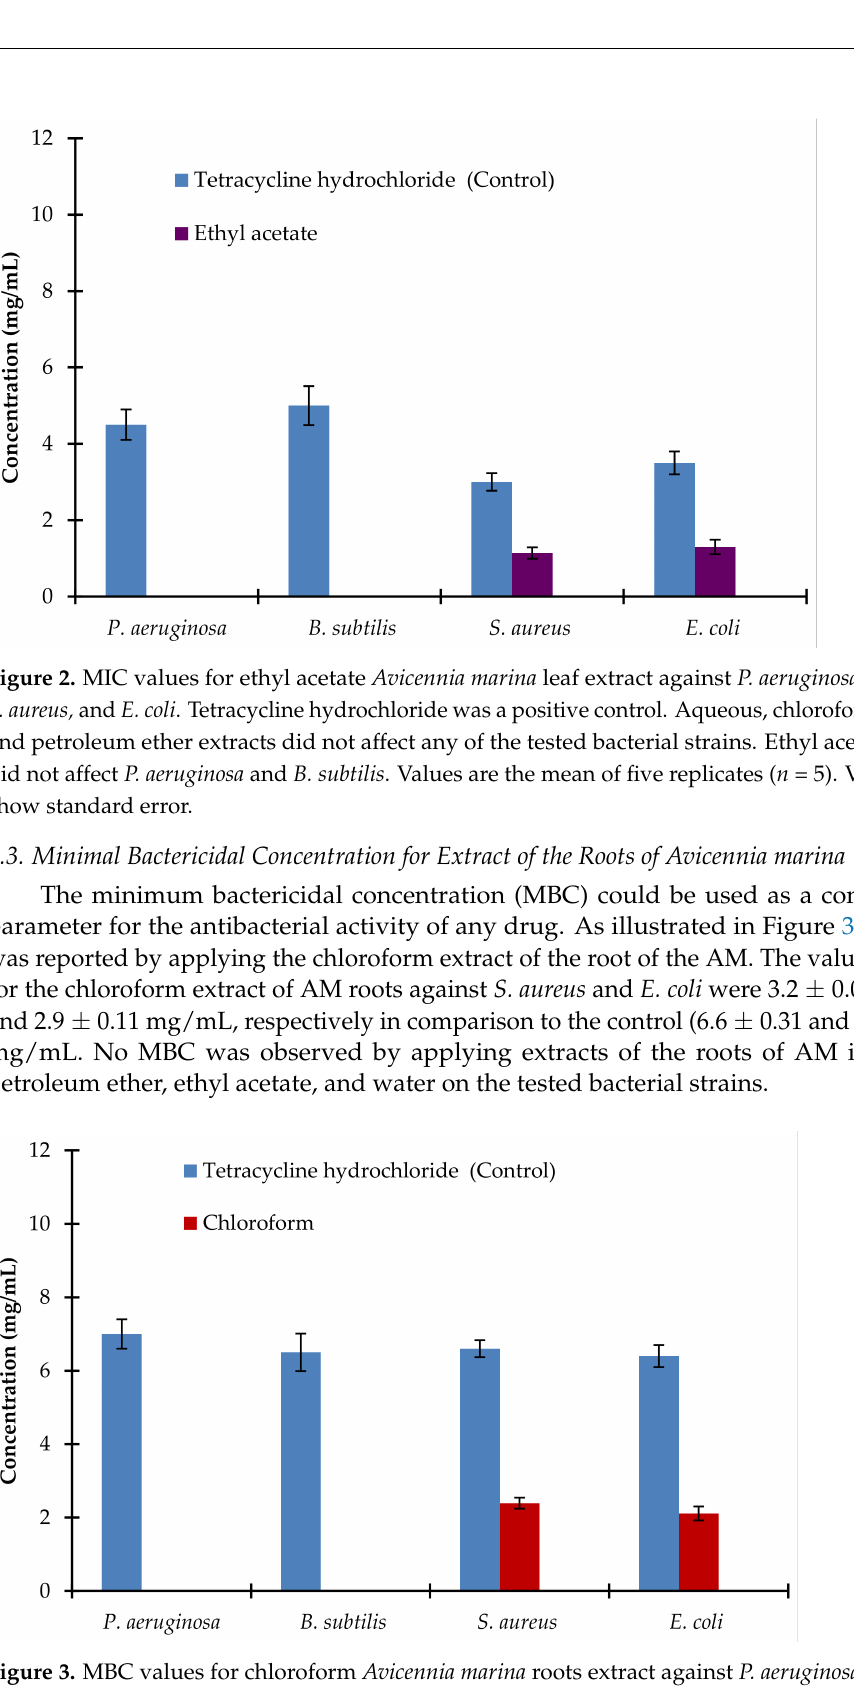
Figure 3. MBC values for chloroform Avicennia marina roots extract against P. aeruginosa, B. subtilis, S. aureus, and E. coli . Tetracycline hydrochloride was a positive control. Aqueous, ethanol, petroleum ether, and ethyl acetate extracts did not affect any tested bacterial strains. Chloroform extract did not affect P. aeruginosa and B. subtilis . Values are the mean of five replicates ( n = 5). Vertical bars show standard